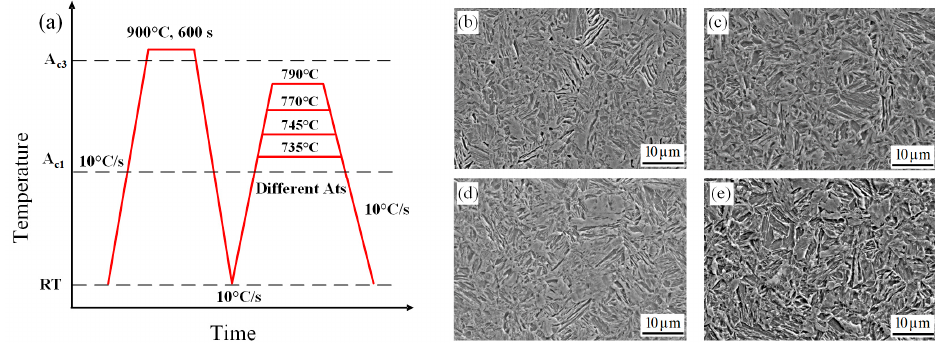
Figure 1. Final heat-treatment process and representative microstructure images of alloys with different compositions: ( a ) heat-treatment process, ( b ) Steel A, ( c ) Steel B, ( d ) Steel C, and ( e ) Steel D.